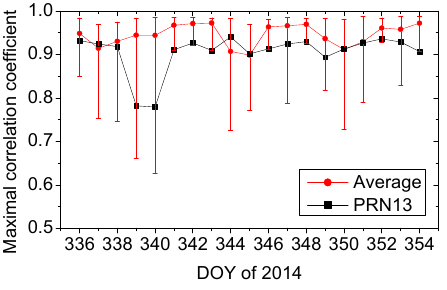
Figure 7. Maximal correlation coefficients (in RCM) of residual time series of each two consecutive days from DOY 335 to 354, 2014. The black squares are the maximal correlation coefficients for PRN 13. The red circles are the average maximal correlation coefficients of all the satellites with the repeat time in the normal range; the upper bound is the maximum of maximal correlation coefficients of all the satellites for each day; the lower bound is the minimum of that for each day.